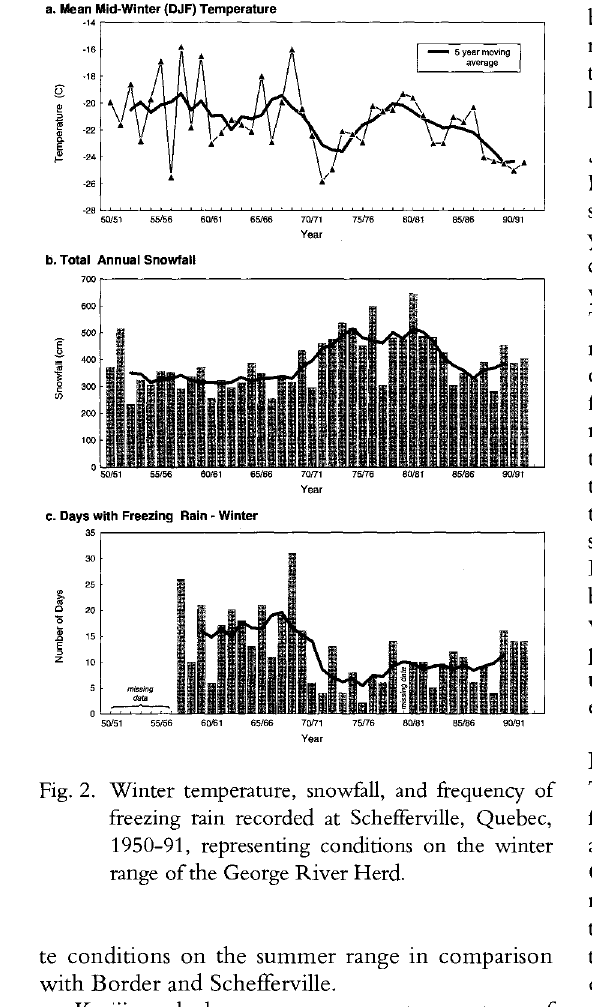
Table 3. Interstation correlations (r) for summer range of the George River Herd. The upper value in each pair refers to summer temperature and the lower to total summer